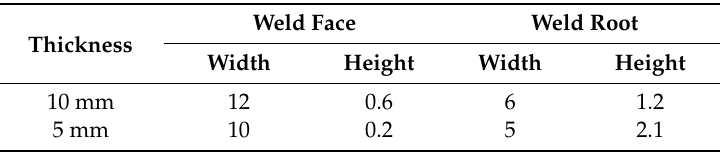
Table 4. Detailed size of weld bead.